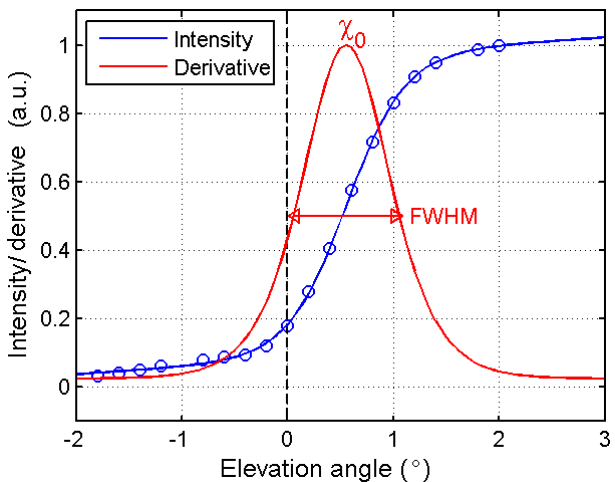
Figure 4. Horizon scans measured by IUP-Bremen on 14 Septem- ber 2016 in the visible wavelength range. The blue circles display the intensity at 440nm plotted as a function of the elevation an- gle reported by the instrument. Measured points are fitted by least- squares minimisation using an error function (blue line) allowing to estimate the horizon elevation ( χ 0 ) and effective field of view (FWHM) (see Sect. 3.2). The corresponding Gaussian curve (ana- lytical derivative of the fitted blue curve) is represented in